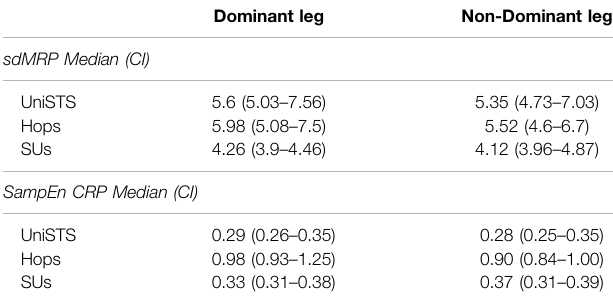
TABLE 2 | Linear and nonlinear coordination variability analysis of the dominant and nondominant legs results in the UniSTS, Hops, and